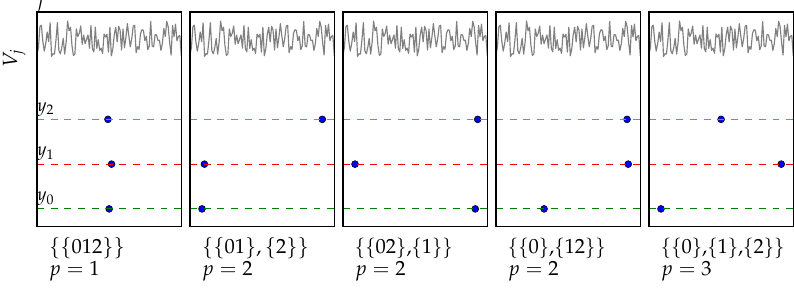
} , corresponding to k = 3. The figure of , y , y 0 1 2